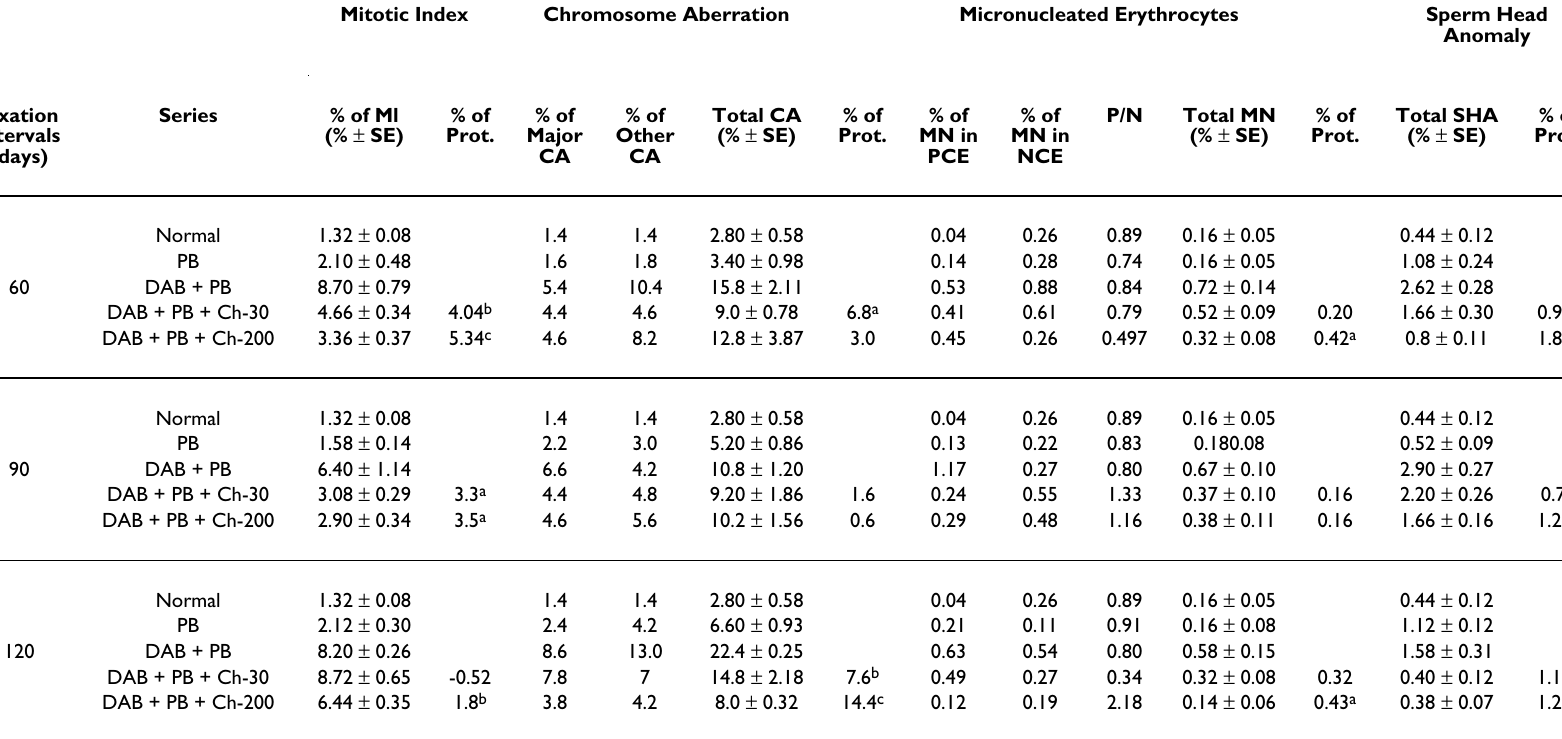
chromatic (NCE) erythrocytes in 5000 cells and sperm head anomaly (SHA) in 5000 sperm in mice treated with p-Dimethylaminoazobenzene (DAB) + Phenobarbital (PB), DAB + PB + Chelidonium (Ch)-30 and DAB + PB + Chelidonium (Ch)-200 and their Phenobarbital treated and normal controls. Equal number of cells/sperms observed from each of 5 mice of a